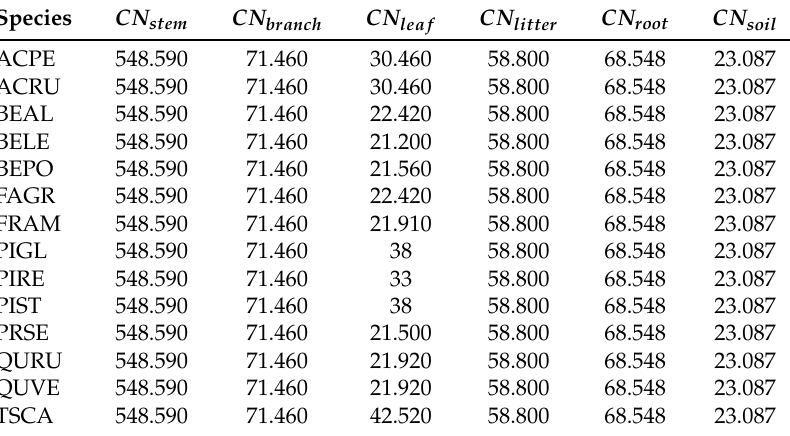
Table A7. Species C:N ratio parameters.